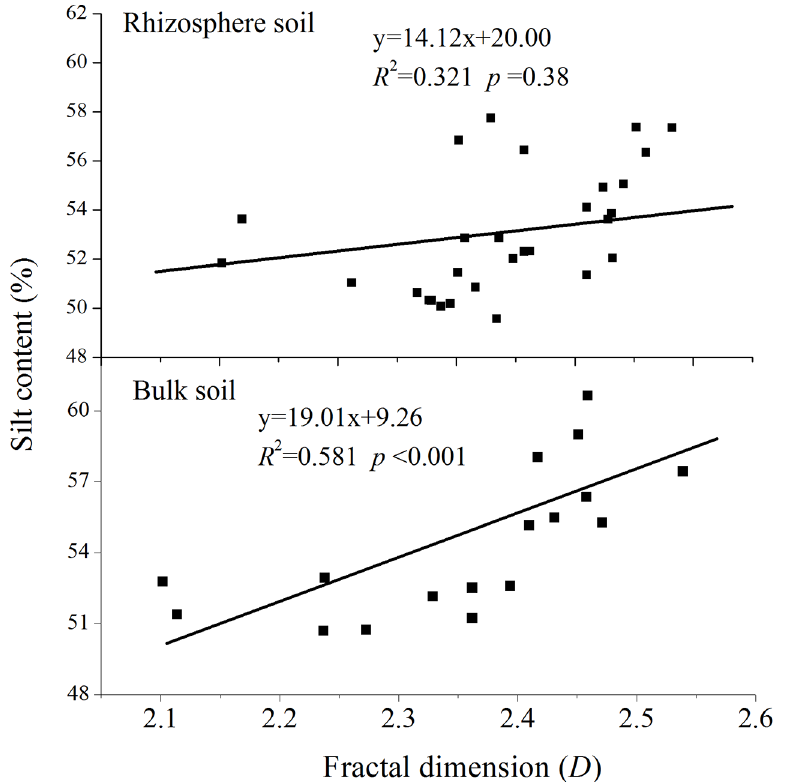
Fig 4. Relationships between fractal dimension and soil silt